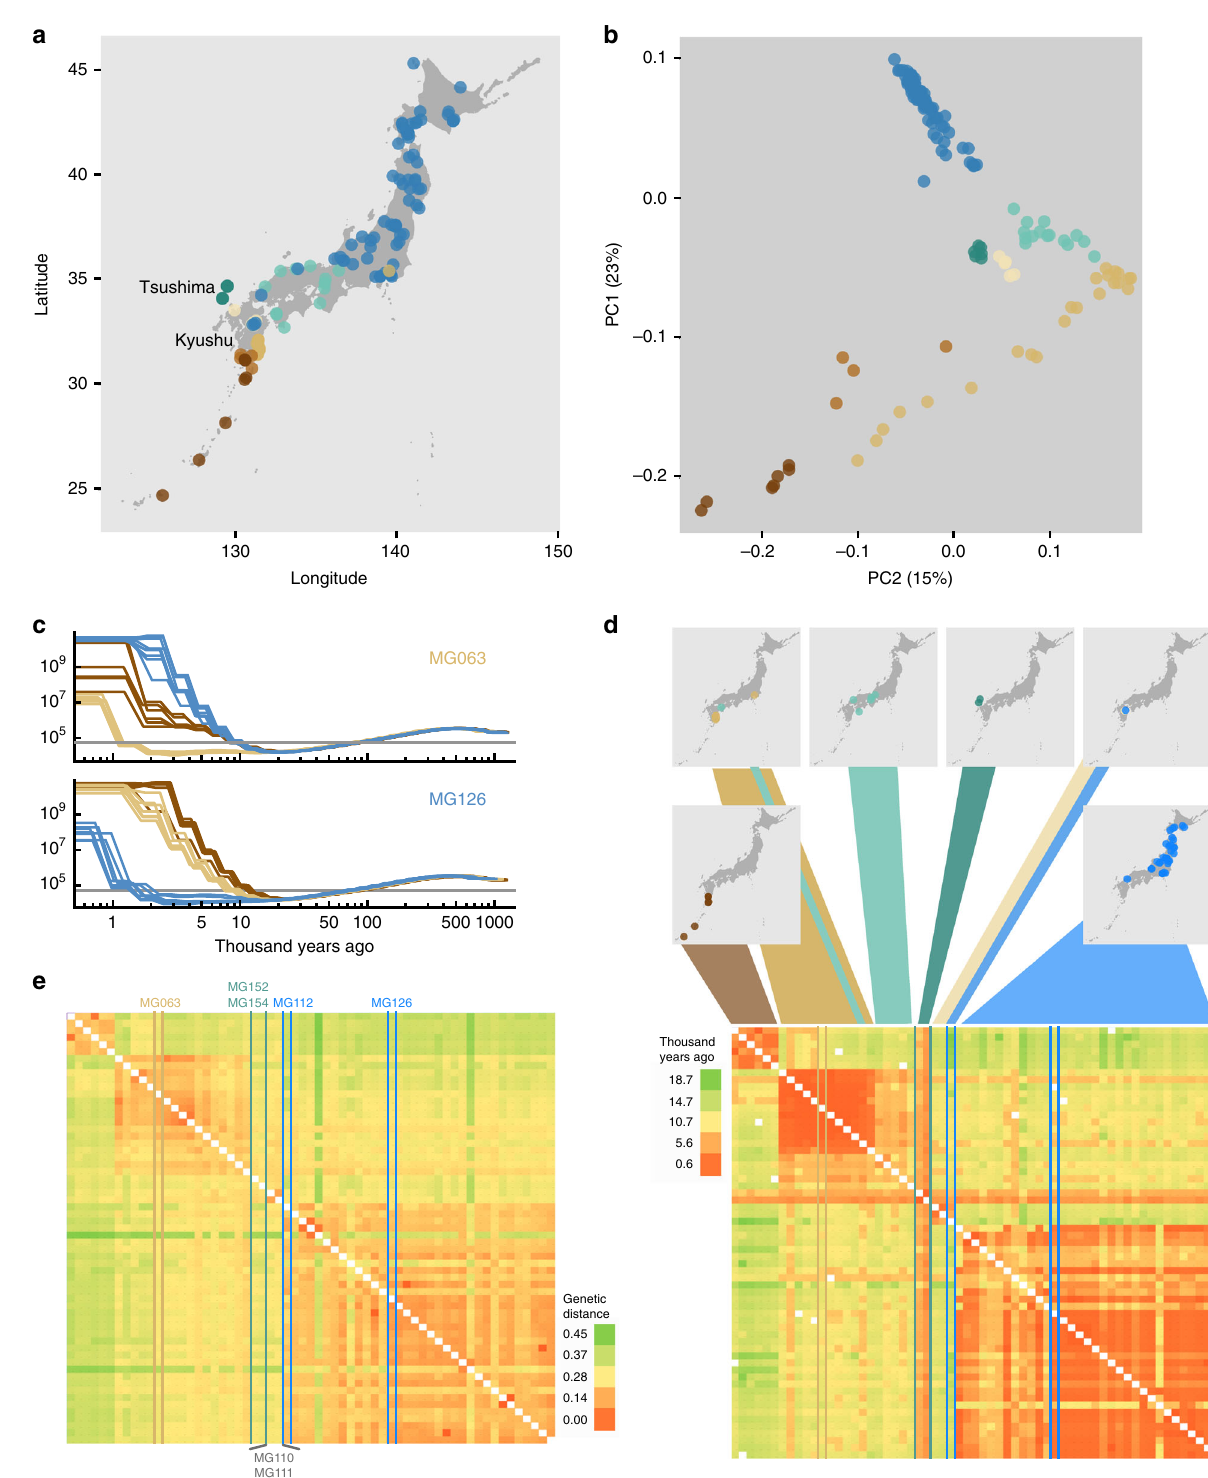
Fig. 1 Geography and genetics of Japanese Lotus accessions. a Geographical origin of the Lotus accessions. b Principal component analysis (PCA) based on the genotypes of the Lotus accessions. a – b Accessions are colored according to their grouping in the PCA plot. c Pairwise sequentially Markovian coalescent (PSMC) curves based on pseudo-diploids generated by merging alignments of pairs of accessions. Each curve indicates the inferred population size history through time for pseudodiploid pairs including MG063 and MG126, respectively. The horizontal gray line indicates an effective population size of 5 × 10 4 . d The lower panel shows a heatmap of divergence times (years ago) for pseudodiploid pairs as estimated from the PSMC analysis with a population size cutoff of 5 × 10 4 . Accession colors are matched in a – e . e Heatmap showing the genetic distances between pairs of accessions. Genetic distance indicates the average number of allelic differences per polymorphic site in a pairwise comparison. d , e Accessions MG152 and MG154 from Tsushima Island (green), MG110 and MG111 (gray) and MG112 (blue) from central Kyushu, MG126 from northern Japan, and M063 from eastern Kyushu are highlighted as indicated in e . The accessions are shown in the same order in d and e . Source data underlying d and e are provided as a Source Data fi